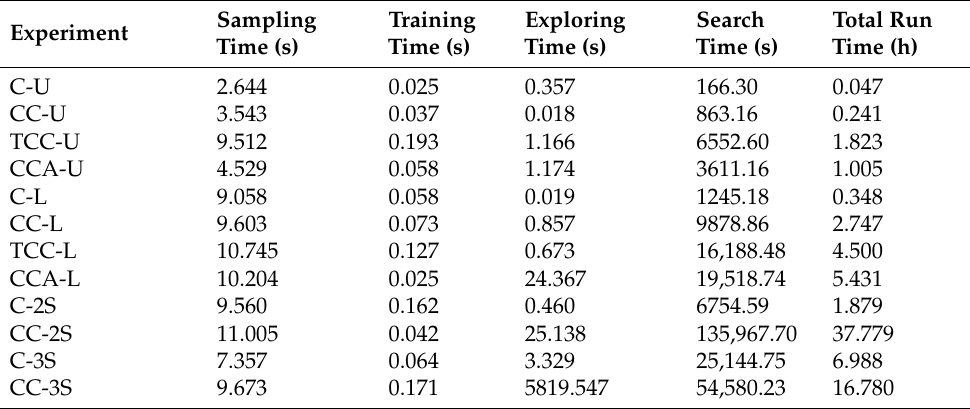
Table 8. Breakdown of the total computational